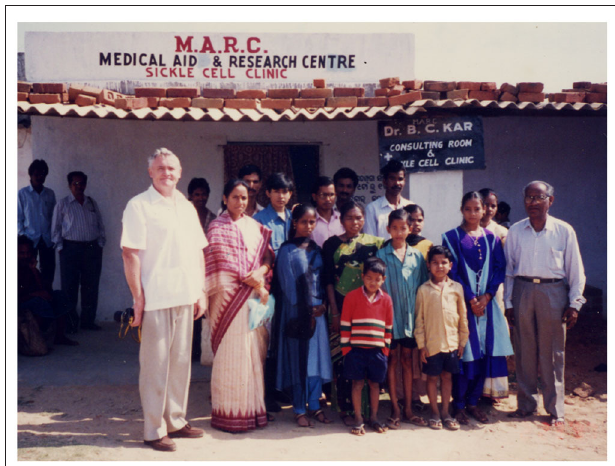
FIGURE 1 | Professor Bimal Kar (right) with the patients at his post-retirement clinic in Burla Market, Odisha, India.